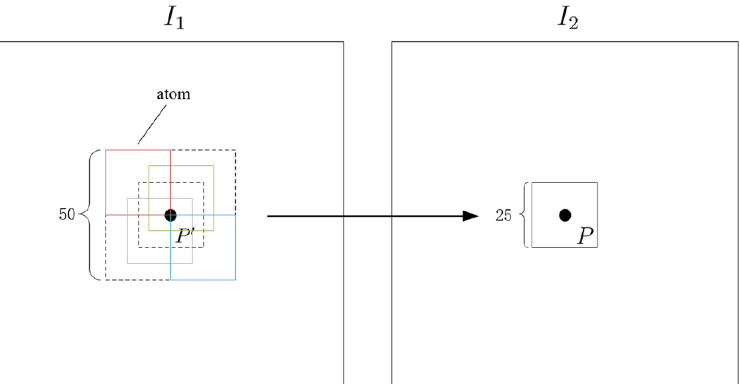
Figure 3. The construction of local dictionary.